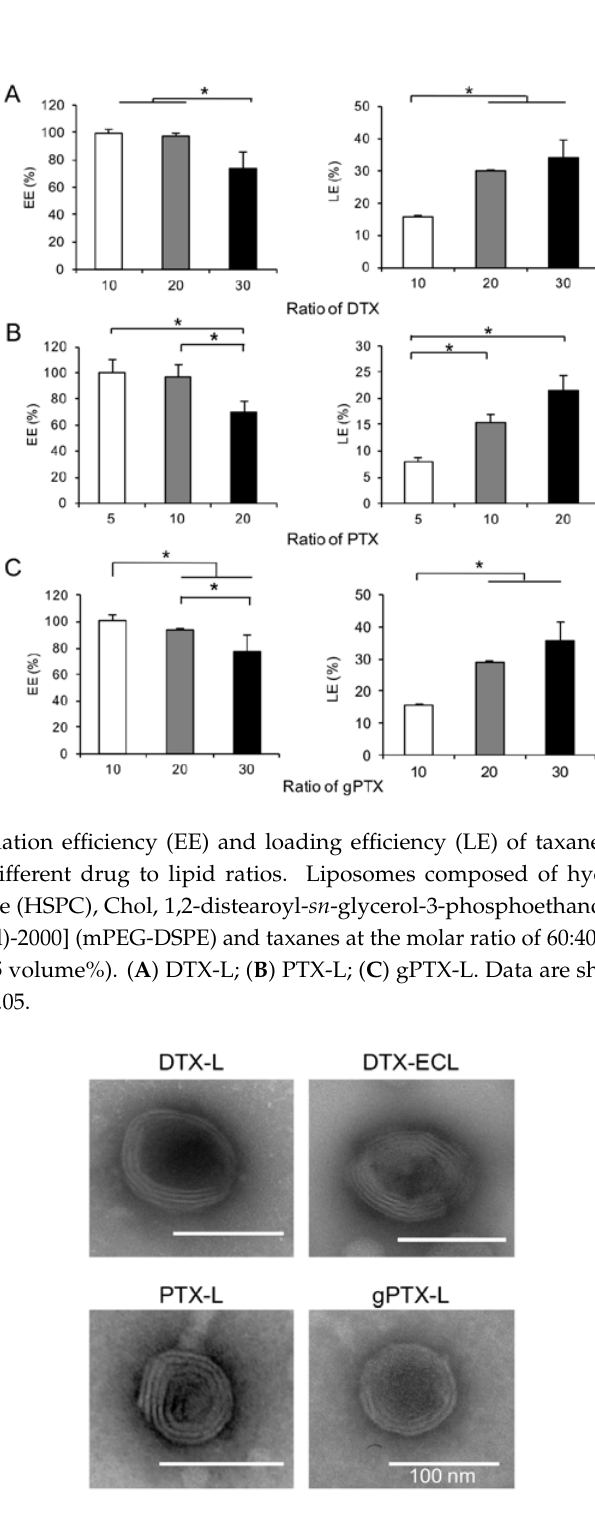
Figure 2. TEM images of liposomes encapsulating taxanes. Liposomal formulations of DTX-L, DTX-ECL, PTX-L, and gPTX-L were observed under TEM. All bars indicate 100 nm.